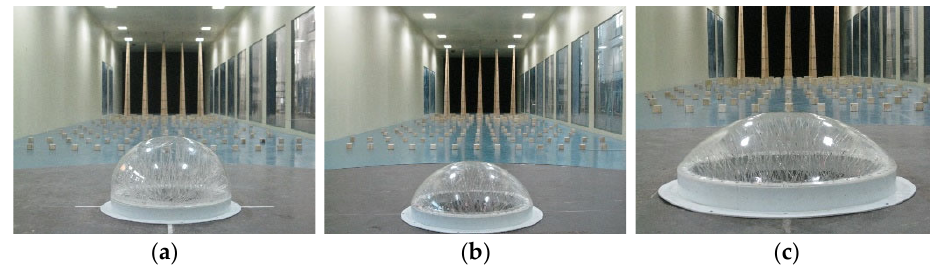
Figure 4. Photos of experiment models: ( a ) H / L = 0.25; ( b ) H / L = 0.33; ( c ) H / L = 0.50.